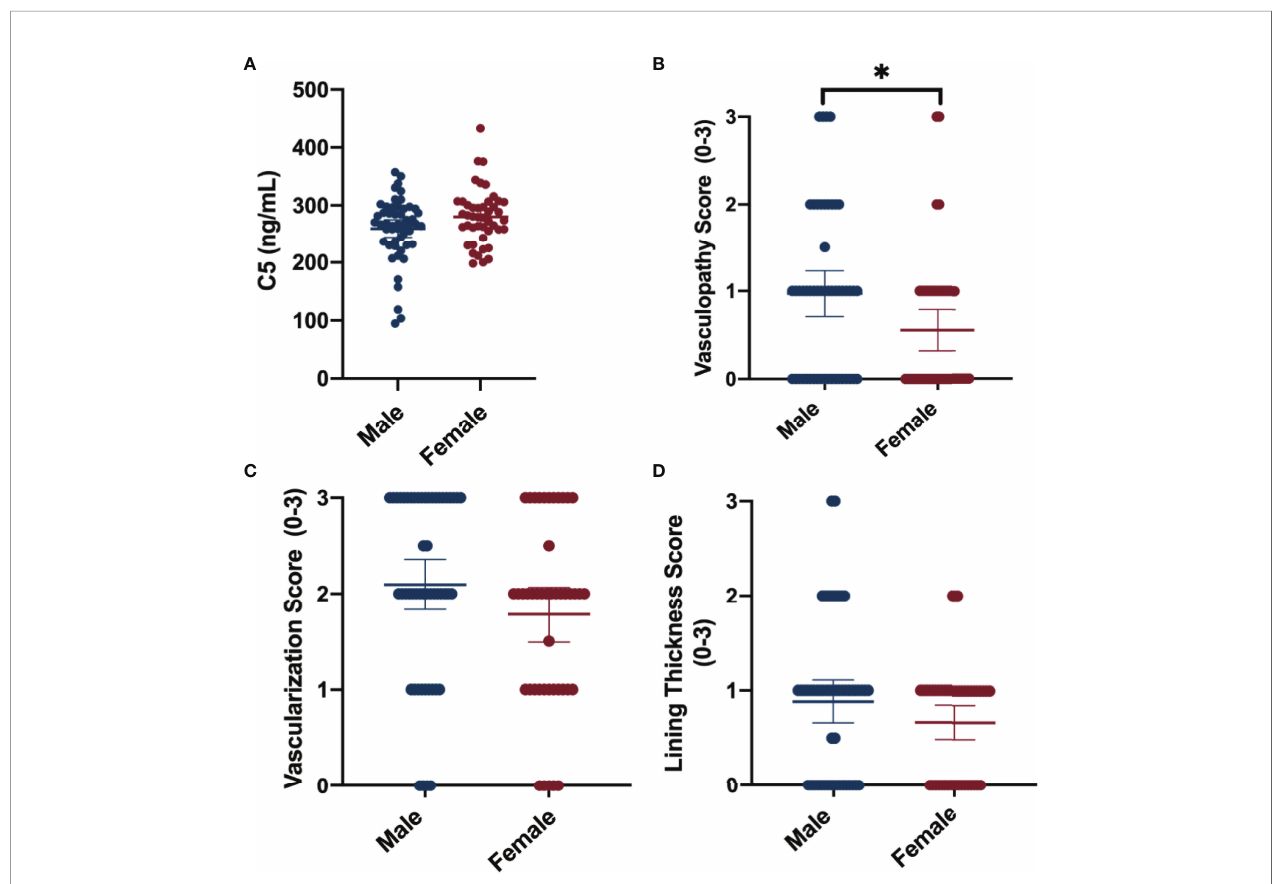
FIGURE 1 | Summary of sex -differences in complement and synovial vascular pathology. Data shown include means ± 95%CI and mean differences between sexes for (A) synovial fl uid C5 concentrations (ng/mL), (B) median vasculopathy score, (C) median vascularization score, and (D) median synovial lining thickness score. Vascular pathologies were scored on a scale of 0 to 3 (none-severe). *P-value